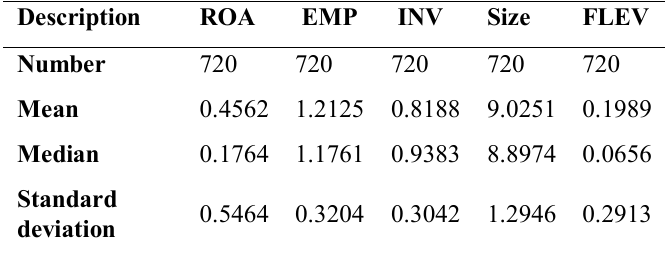
Table 2-Descriptive statistics of the sample